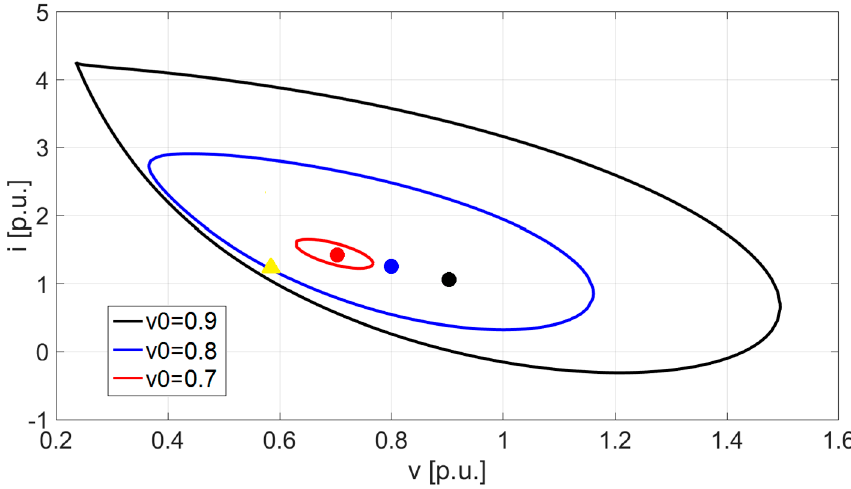
Figure 3. Basins of attraction (BAs) corresponding to shifted equilibrium points.